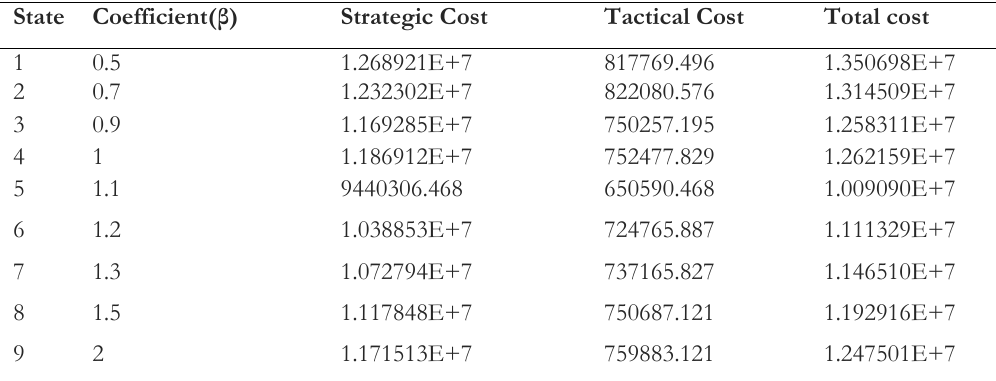
Table 8. Objective function changes based on the changes in capacity